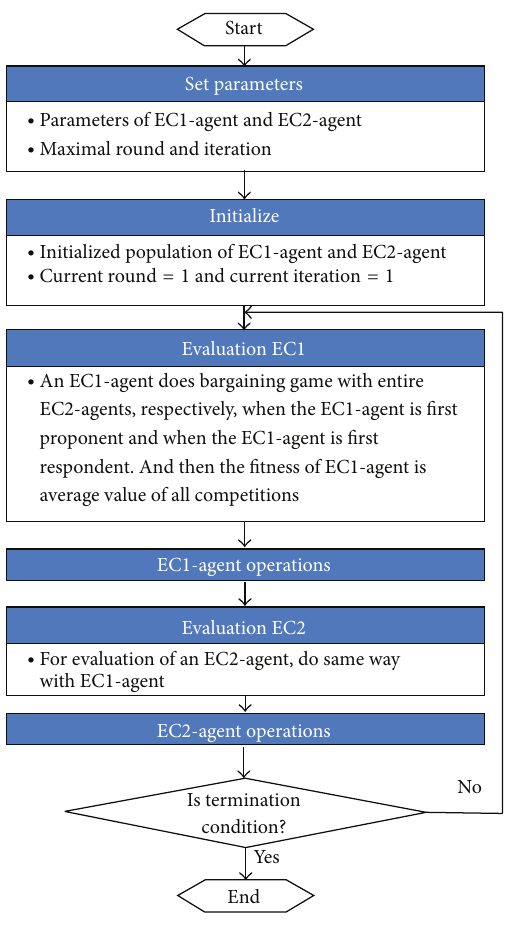
Figure 5: Coevolution model between two EC-agents in bargaining